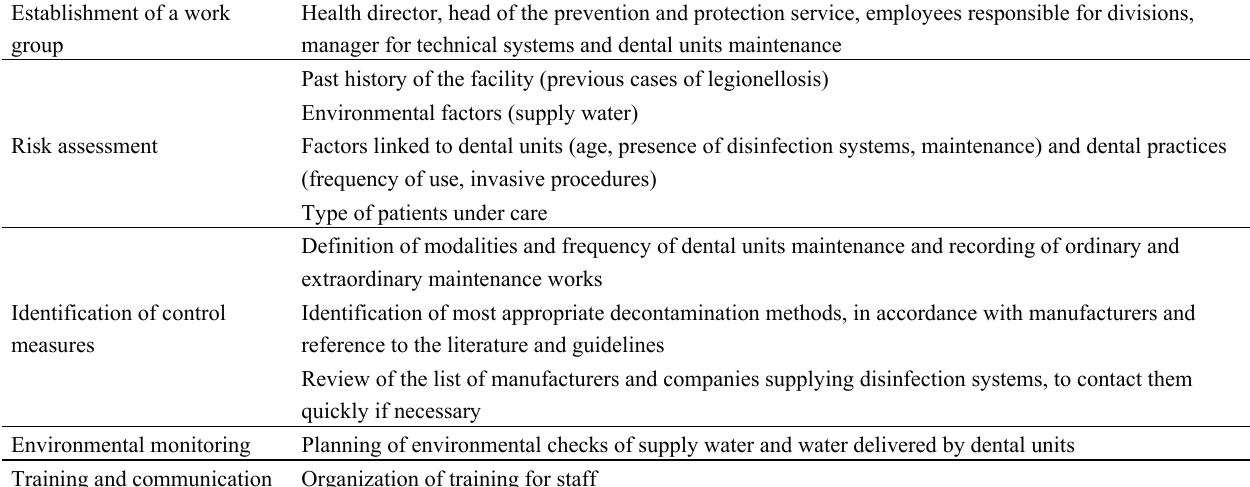
Table 2. Main steps in the definition of the internal quality plan for the control of Legionella contamination in dental health care